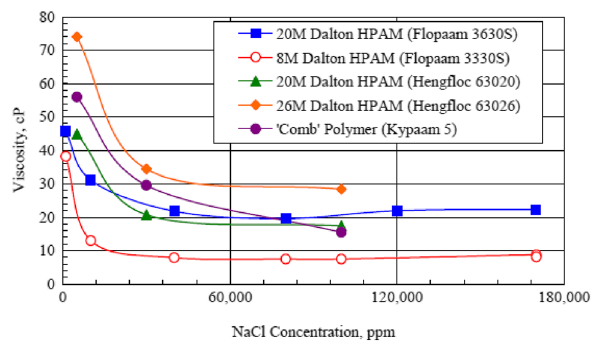
Fig. 4 Salinity effect on HPAM viscosity (from Levitt and Pope 2008)